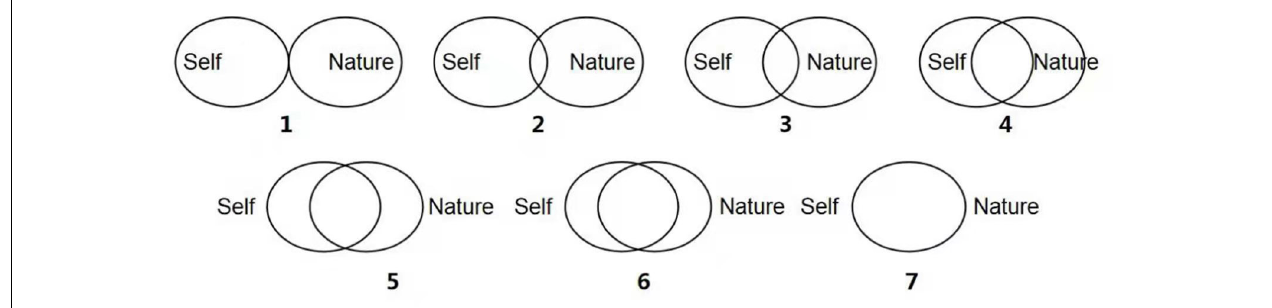
FIGURE 1 | Inclusion of nature in self scale (INS).